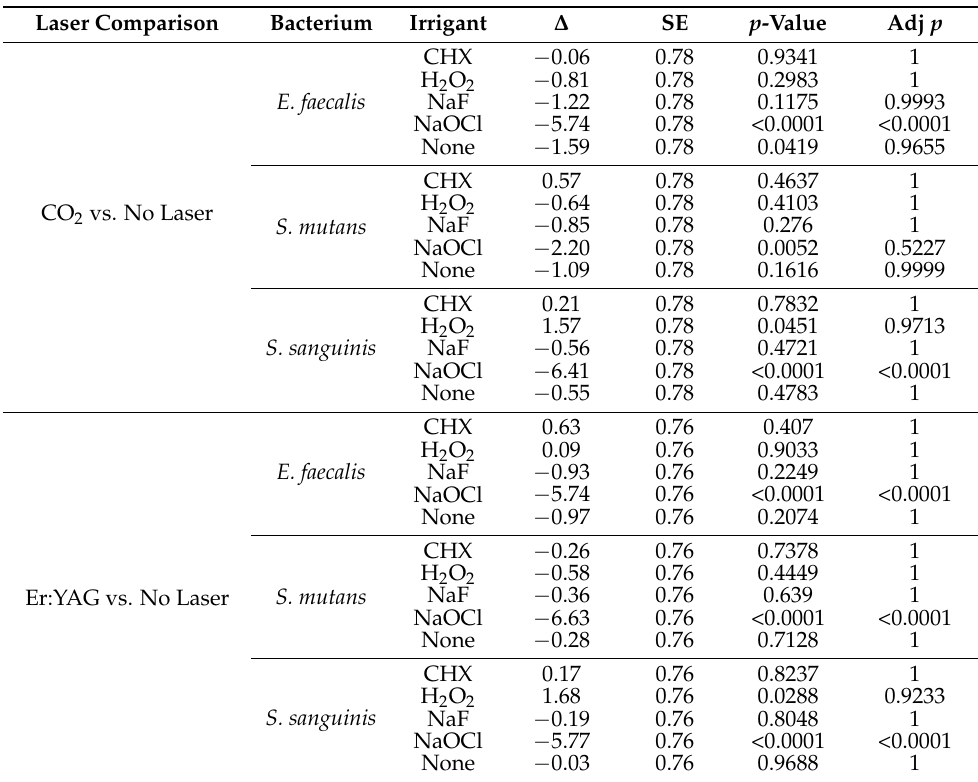
Table 2. Pairwise comparisons for the effect of irrigants with and without a laser. Laser